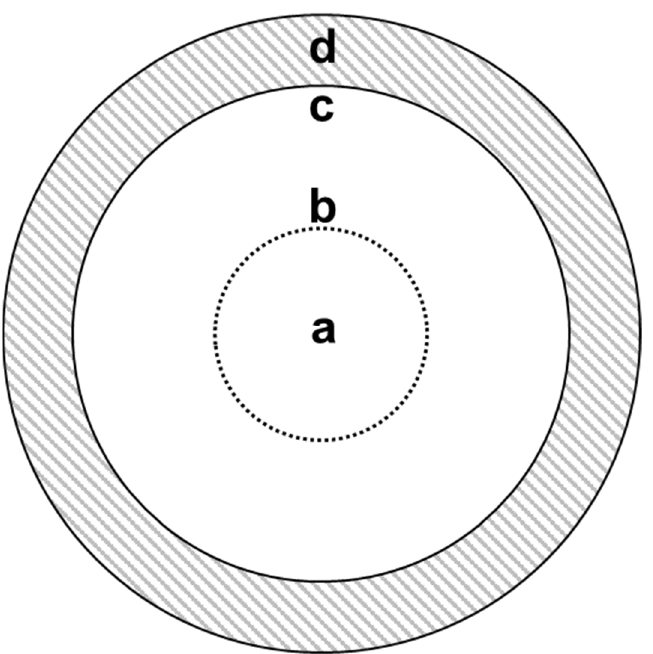
Figure 5. Filter paper arena used in the repellent bioassays. ( a ) Drop zone with a single Haemaphy- salis longicornis nymph, ( b ) start line, ( c ) finish line, ( d ) treated circle. longicornis nymph, ( b ) start line, ( c ) finish line, ( d ) treated